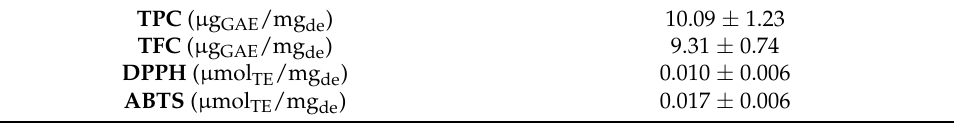
Table 1. Values of total phenolic content (TPC), total flavonoid content (TFC) and antioxidant activities (DPPH and ABTS) in water extracts from asparagus hard stem byproducts. Values are expressed in terms of gallic acid equivalents (GAE) and Trolox equivalents (TE) per mg of dry extract (mg de ).